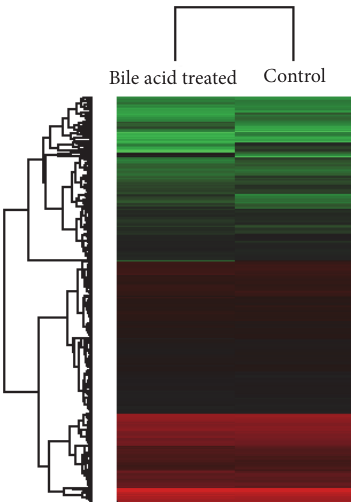
Figure 2: The expression levels of 348 dysregulated proteins are shown in a heatmap. The red-colored clusters represent upregulated proteins and the green-colored clusters represent downregulated proteins.